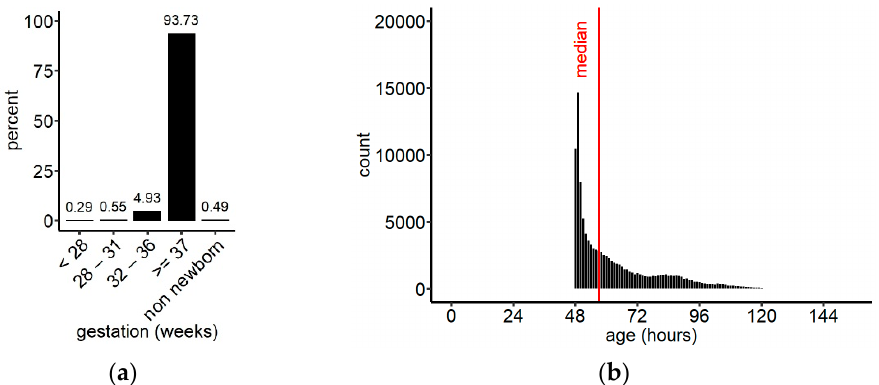
Figure 2. ( a ) Grouping of the screened population by gestational age; ( b ) distribution of sampling ages for newborns irrespective of their gestational age, binned in 1 h intervals. Median (IQR) = 57.1 h (49.9, 72.9); overall, 174 samples were collected after 150 h (data not shown). n = 115,211.